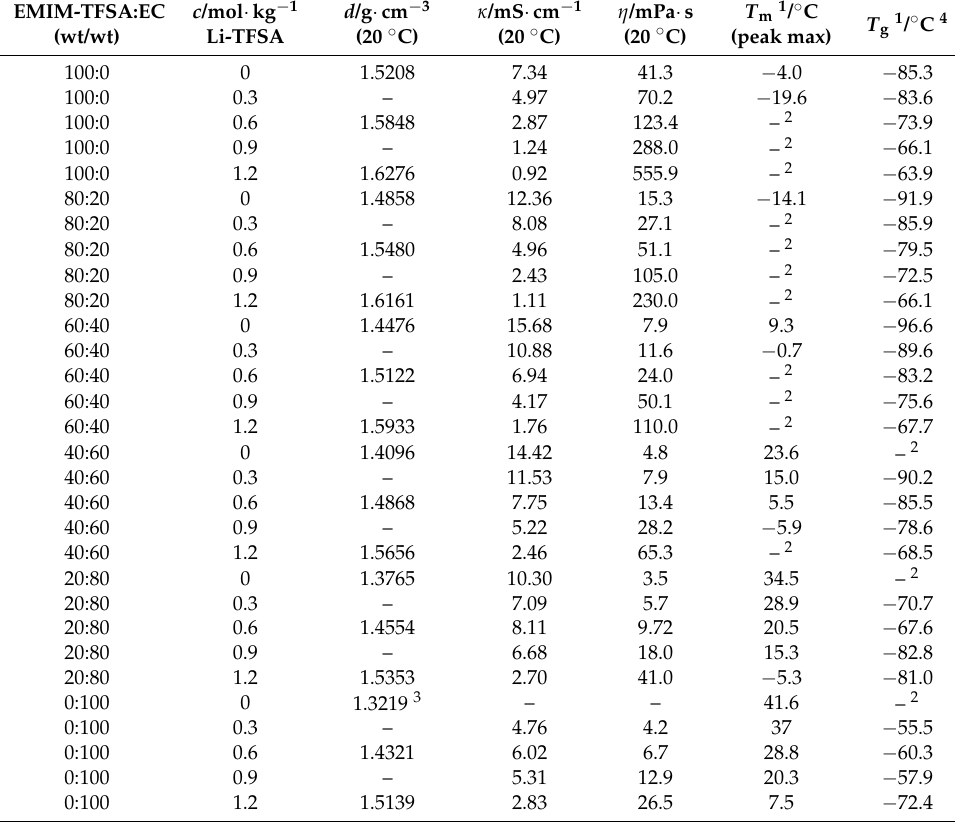
Table 1. Overview of the mixtures and selected properties (density ( d ), conductivity ( κ ), viscosity ( η ), melting temperature ( T m ), glass transition temperature ( T g )). Data of the solvent mixtures at pressure p = 0.1 MPa. Standard uncertainties u are u ( d ) = 0.0005 g ¨ cm ´ 3 ; u ( p ) = 5 kPa; u ( η ) = 0.05 ¨ η ; u ( κ ) = 0.03 κ ; u ( T , viscosity) = 0.1 K; u ( T , density) = 0.01 K; u ( T ; DSC) = 3 ˝ C; u ( T , conductivity) = 0.1